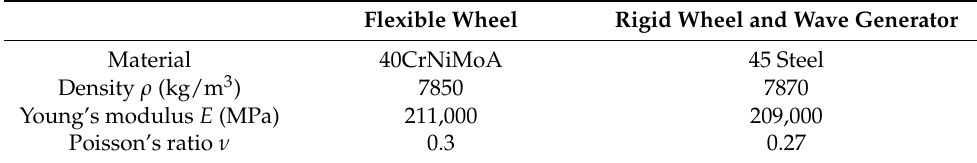
Table 3. Parameters of the flexible wheel, rigid wheel and wave generator. Flexible Wheel Rigid Wheel and Wave Generator Material